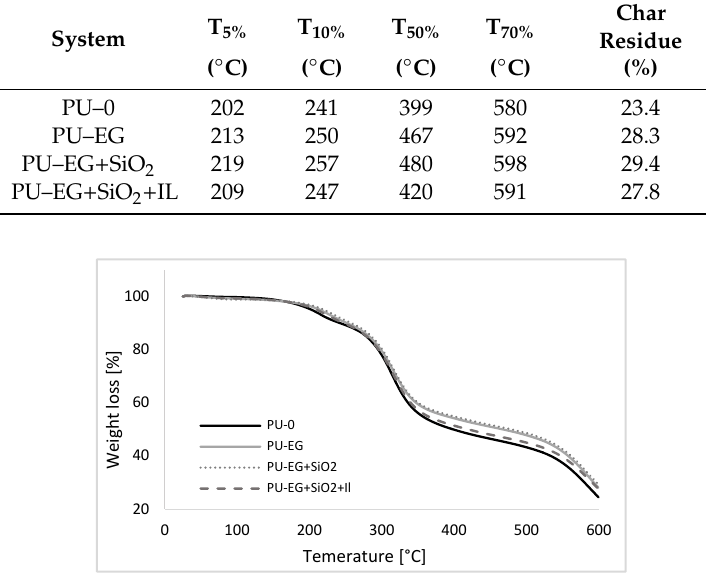
Figure 8. TGA graph plotted for PU foams.